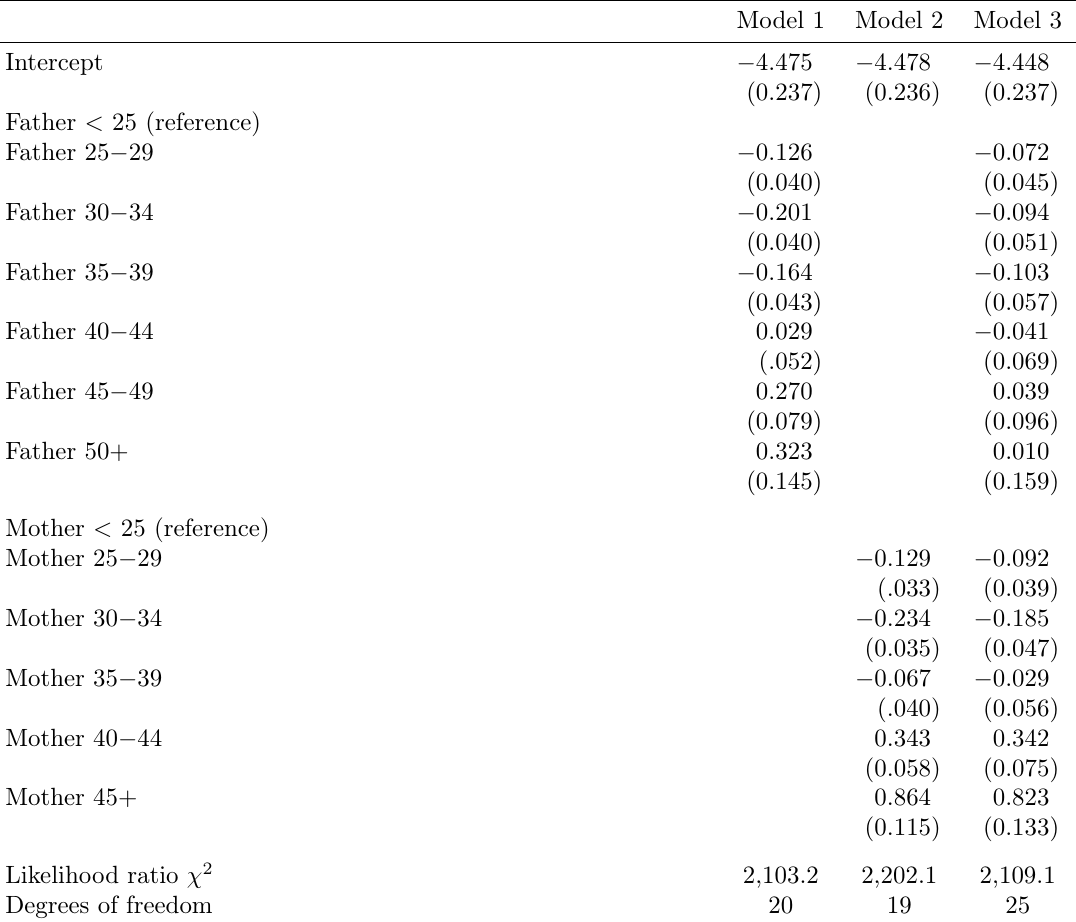
Table 2: Logistic regression coefficients (standard errors) for cognitive disability on parents’ age at birth and other